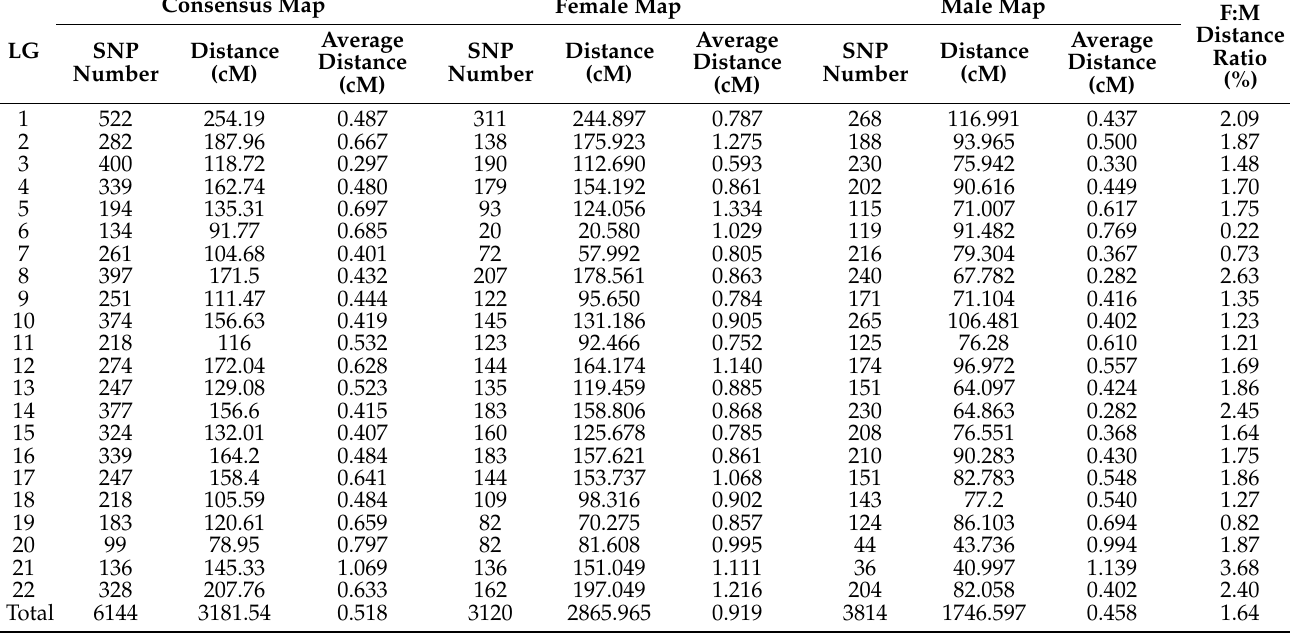
Table 1. Summary of the characteristics of the consensus map and sex-specific genetic maps for A. japonicus